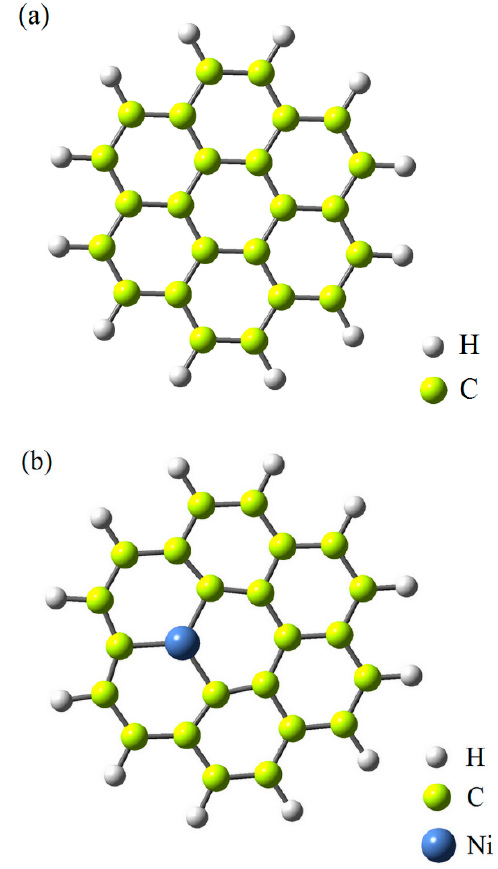
Figure 2. Atomic structure of pure ( a ) and Ni-doped ( b ) graphene flakes.